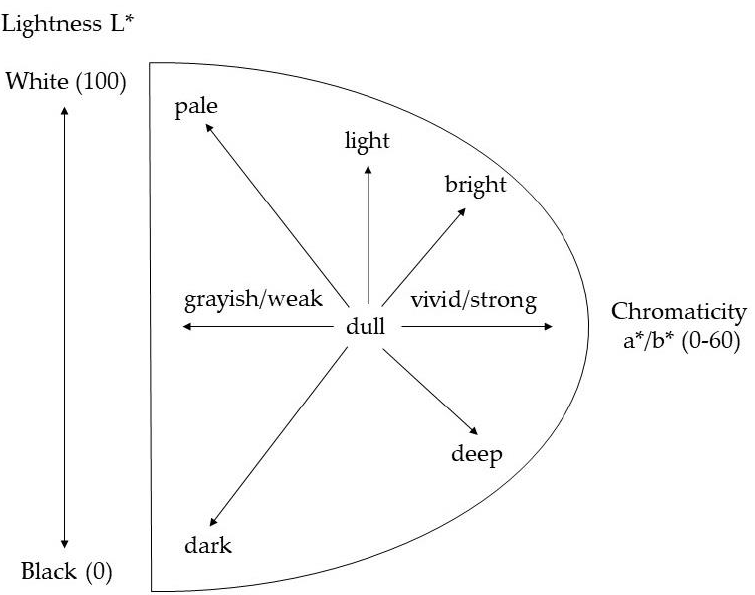
Figure 3. Adjectives of color according to L*, a* and b* values. Adapted from the Konica Minolta CM700D manual https://www.konicaminolta.com/instruments/knowledge/color/part1/07.html (accessed on 4 April 2022).